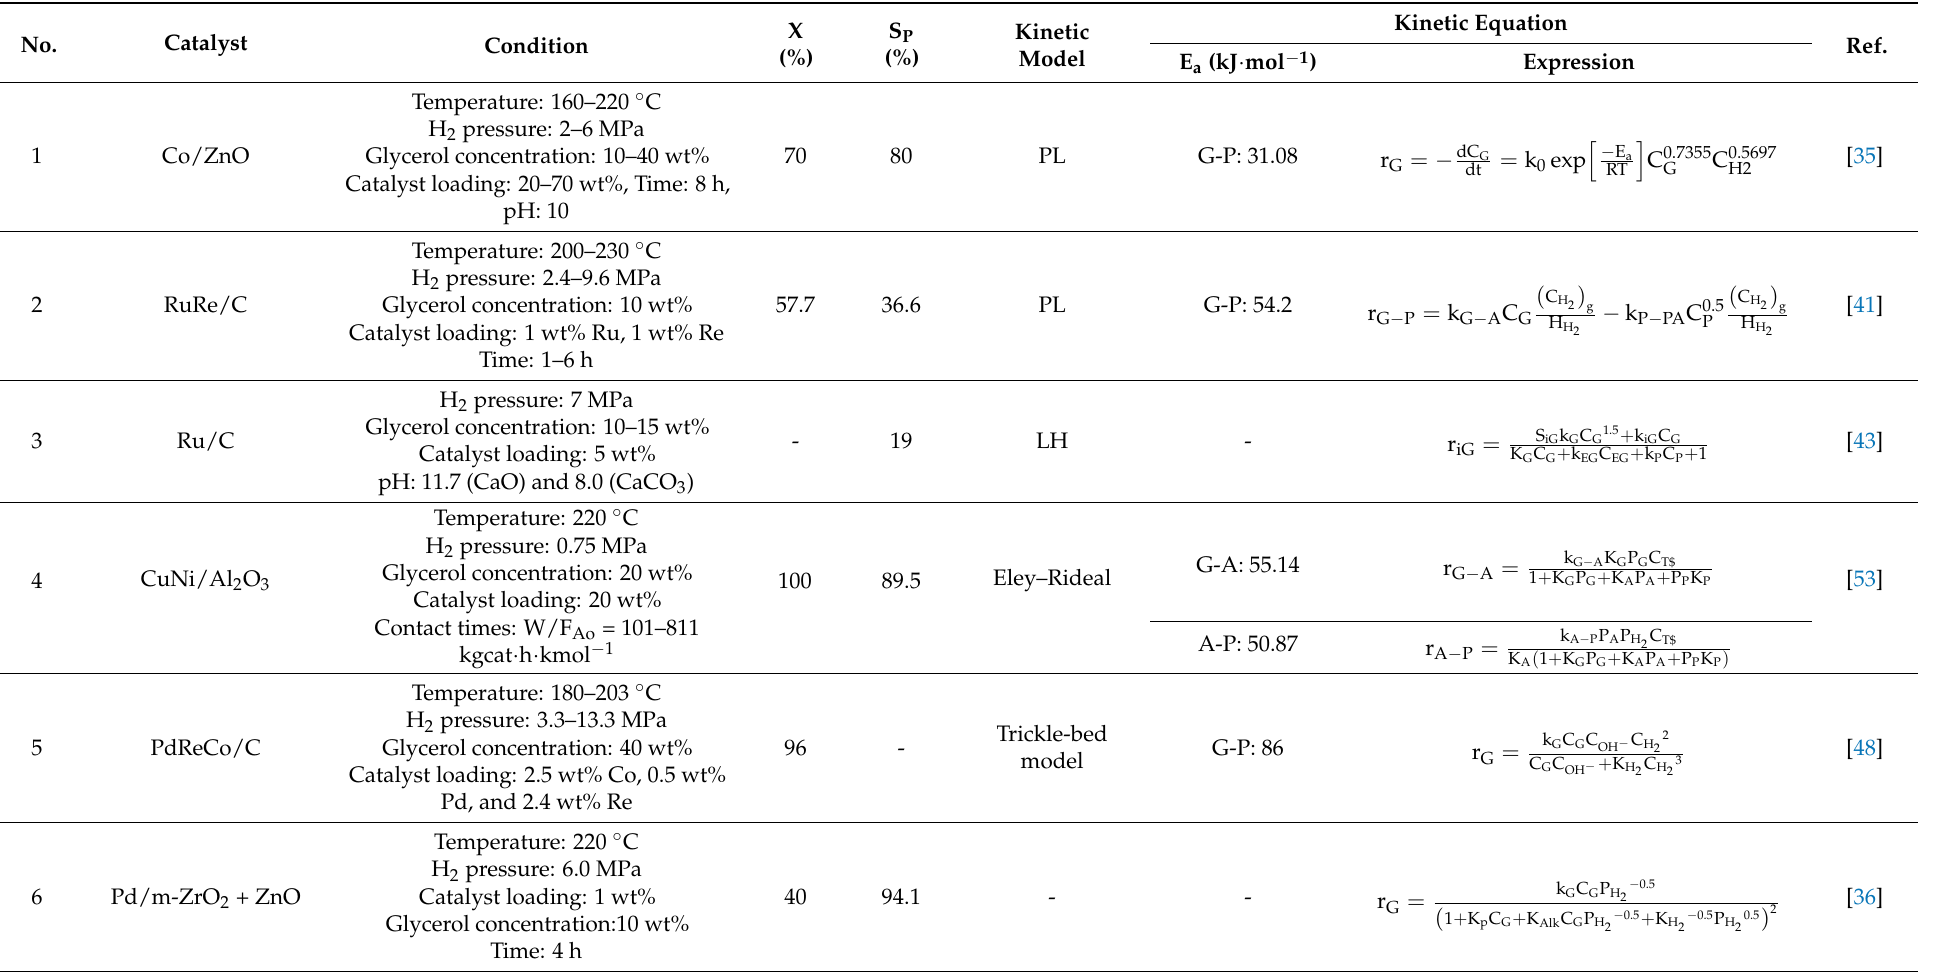
Table 5. Kinetic models over other supported metal